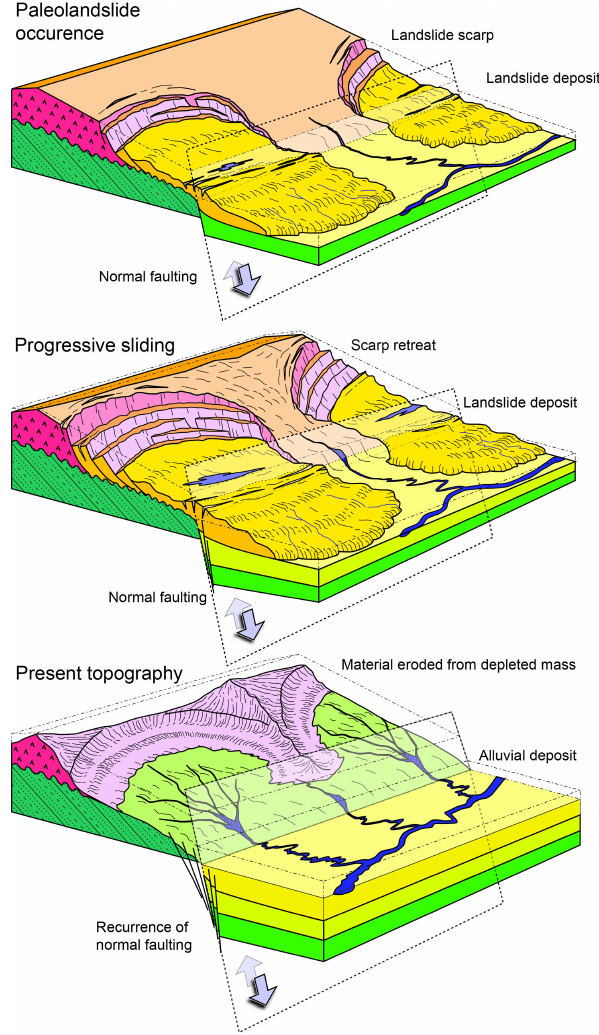
Figure 13. Schematic illustration of the evolution of the landslides. The triggering mechanism may be associated with normal faulting of the JSF (also known as the SCF), which transects the slope toe. The accumulation zone crossing the fault was eroded and trans- ported, resulting in the current plain, as shown in the lower